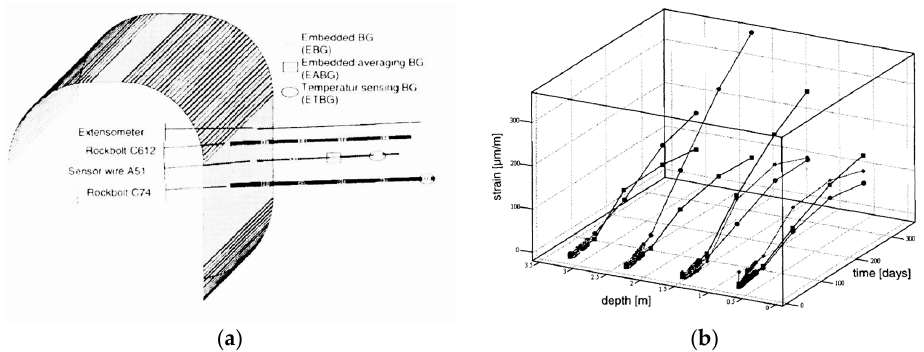
Figure 9. ( a ) Installation of GFRP rock bolts equipped with FBG sensors; ( b ) one year observation of rock movement in the tunnel with the three installed GFRP sensors: wire A51 (diamonds) and rockbolts C612 (squares) and C74 (dots) [43].